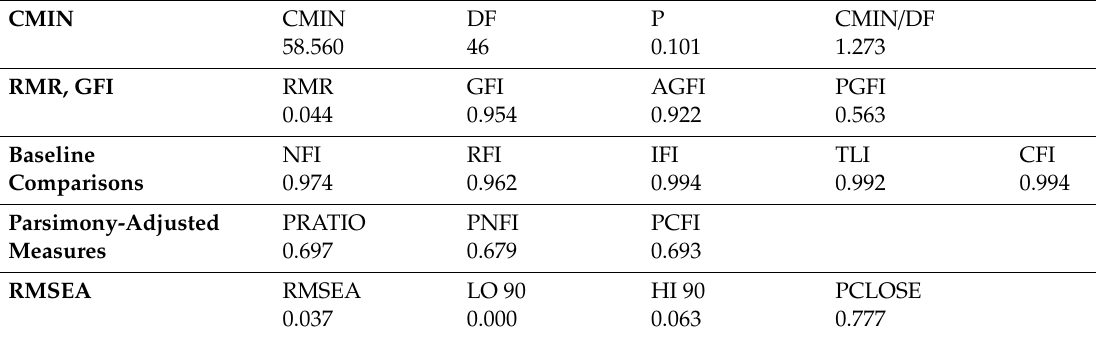
Table 4. Best fitting measurement model